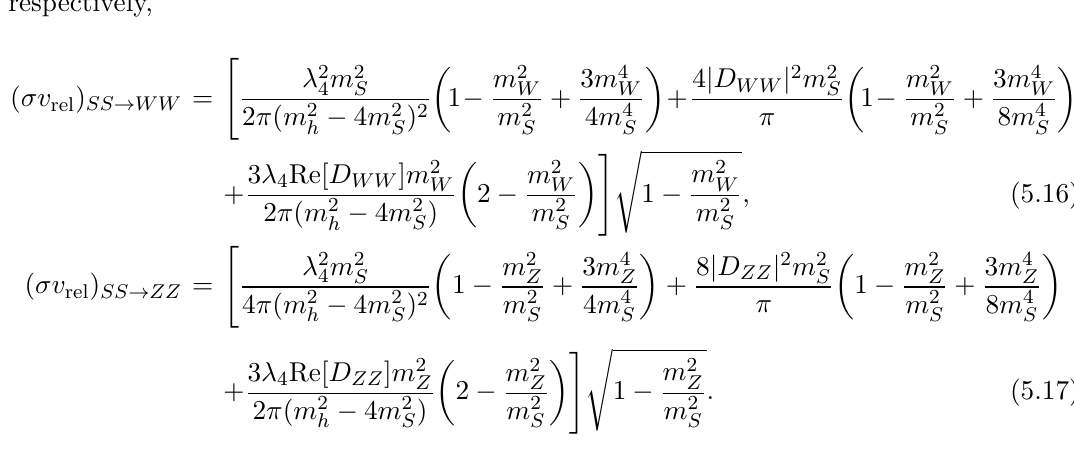
(red) channels are LQ